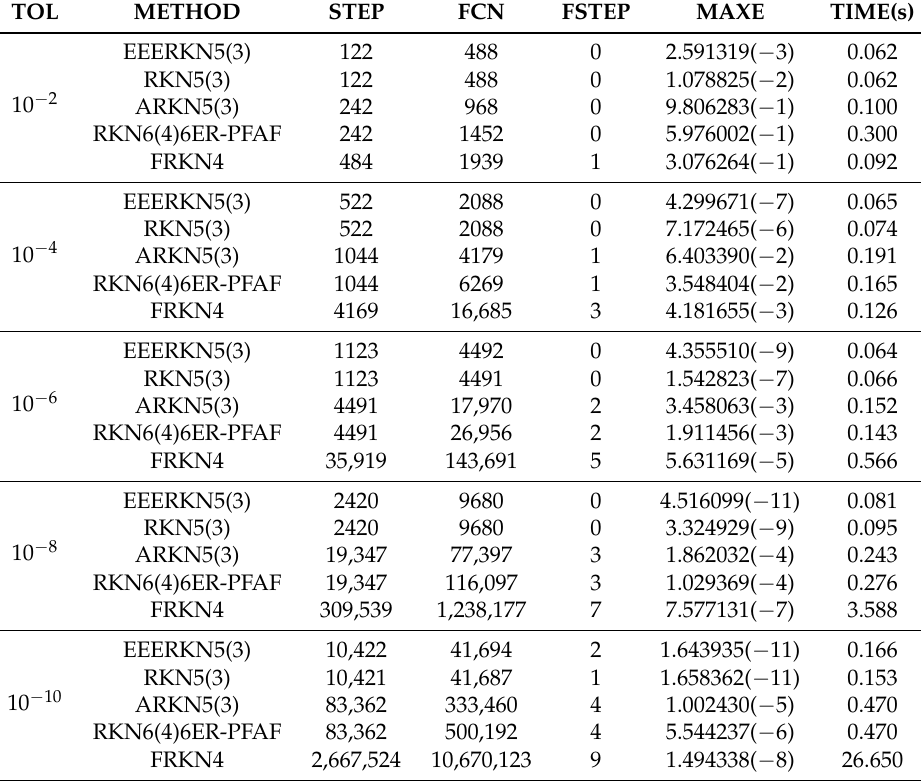
Table 4. Numerical results for Problem